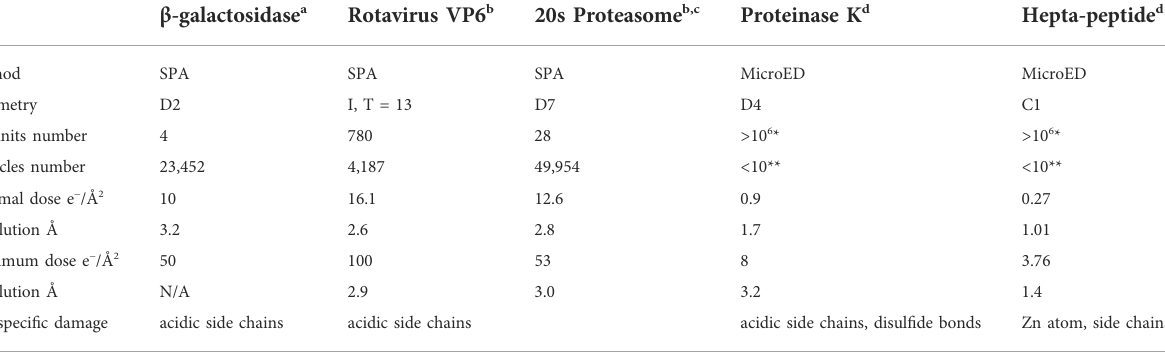
TABLE1RadiationdamageassessmentusingSPAandMicroEDwithbiologicalcomplexes.Resolutionlimitisdeterminedbyglobalgold-standardFSC at 0.145 for SPA and measurable diffraction spots for MicroED, respectively. β -galactosidase a Rotavirus VP6 b 20s Proteasome b,c Proteinase K d Hepta-peptide